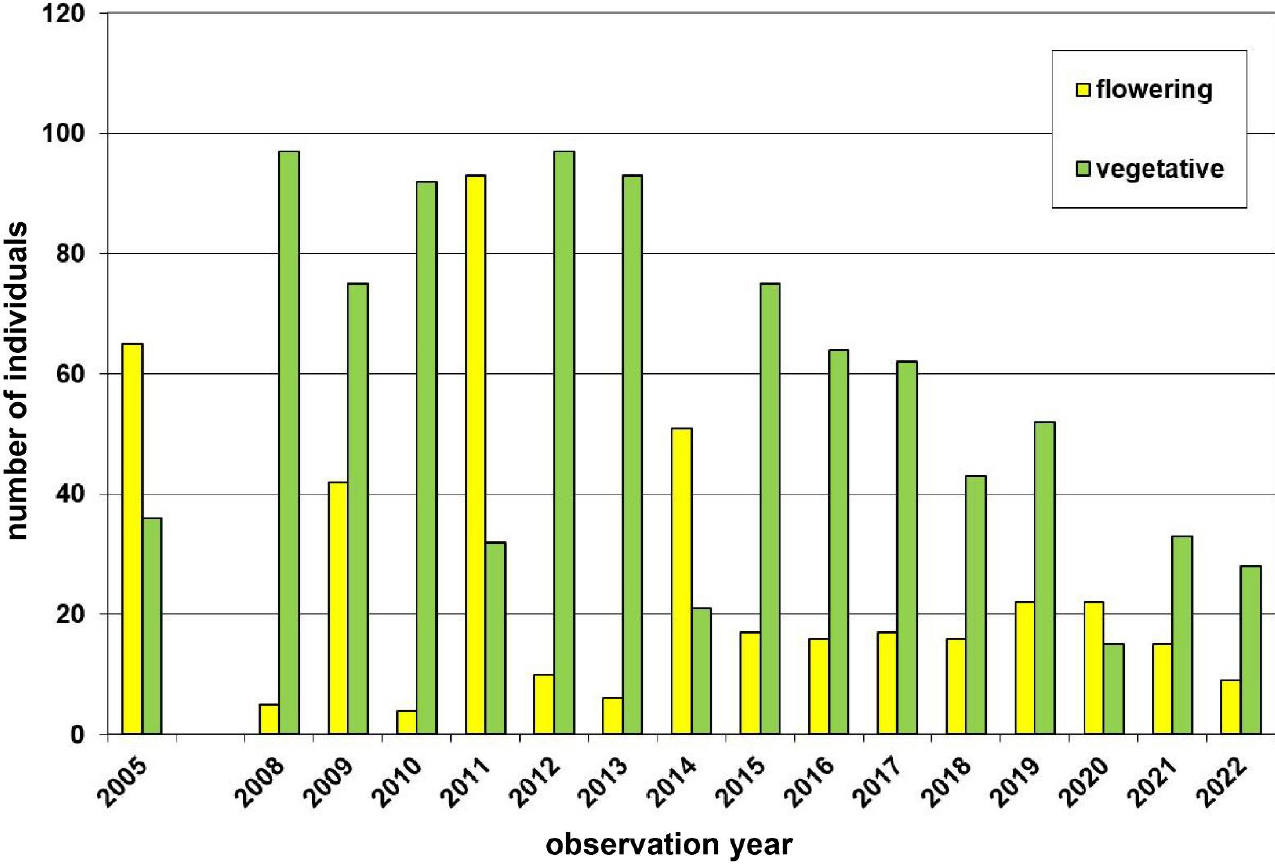
Figure 6. Population census (2005 – 2022) of the Dactylorhiza sambucina -population Mittelberg near Retz (patch M-VIIIa) in the Weinviertel region. This population was not visited by us in the years 2006/2007. Yellow columns = flowering plants and green columns = non-flowering, vegetative plants.